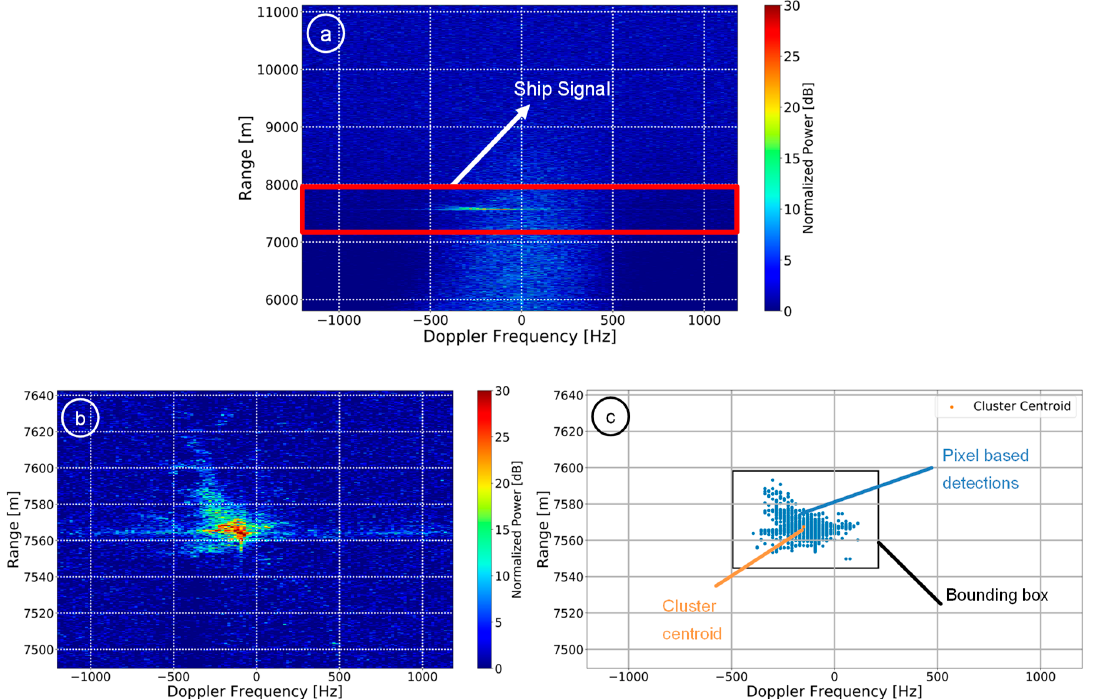
Figure 20. ( a ) Range-Doppler image showing the total range of the complete scene and 128 Doppler bins respectively (cf. black box in Figure 4 bottom right). The ship signal is highlighted by the red box. ( b ) Scaled detail of the red box from ( a ); ( c ) the clustered ship signal with its centroid and the bounding box. The ship pixels shown in this example were detected using the K-distribution.